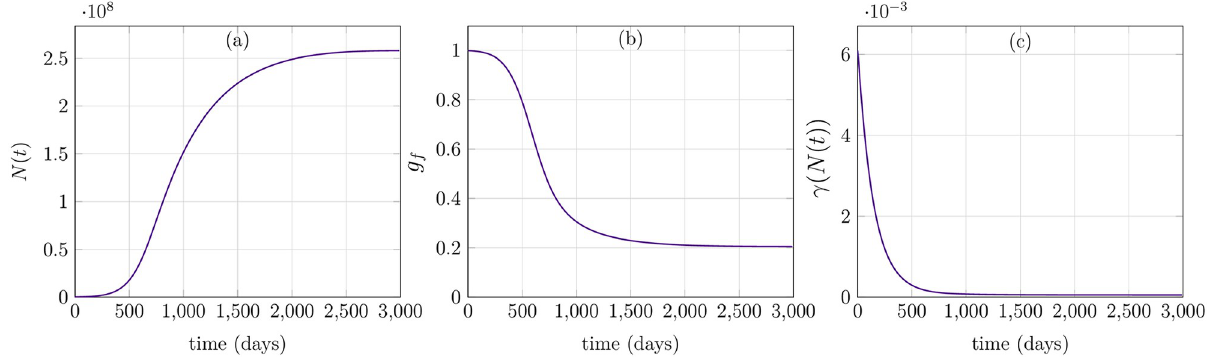
Fig 4. Behavior of total cell population, growth factors and gamma function. (a) N ( t ) achieves steady-state. (b) Growth-factors g f decreasing with increase in cell population. (c) Gamma function γ declines as the total cell population achieves steady-state.